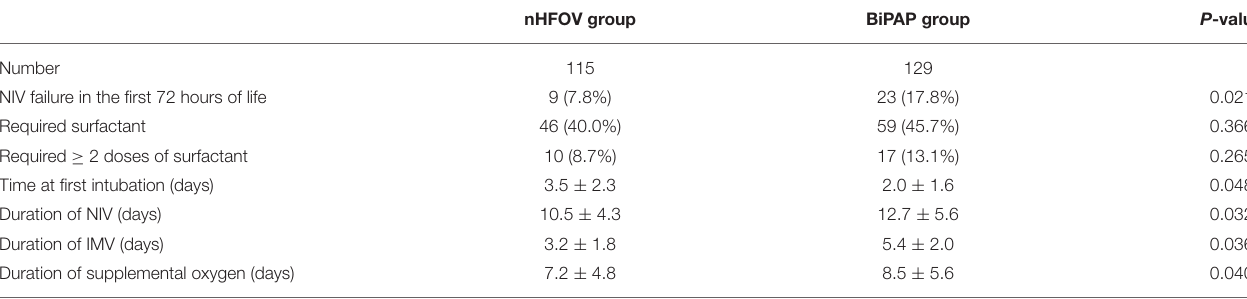
TABLE 2 | Comparison of respiratory status between the two groups.